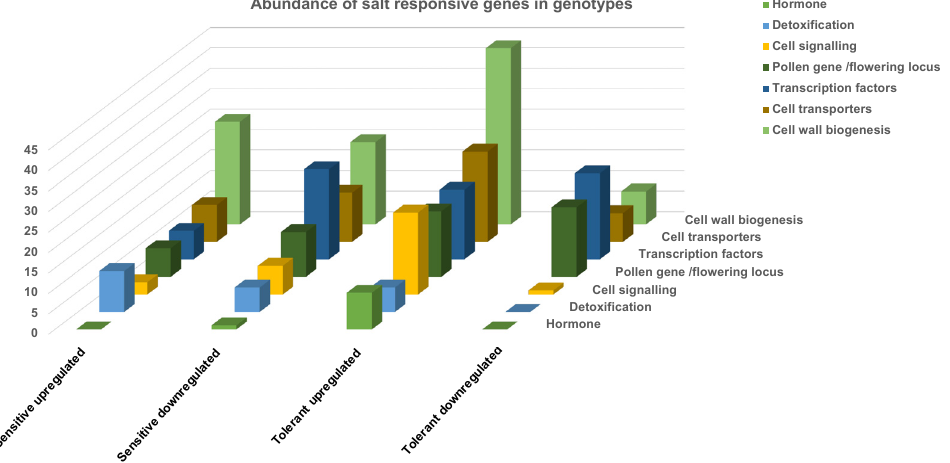
Figure 11. The abundance of gene families involved in hormone signalling and cell wall biogenesis in response to salt stress.